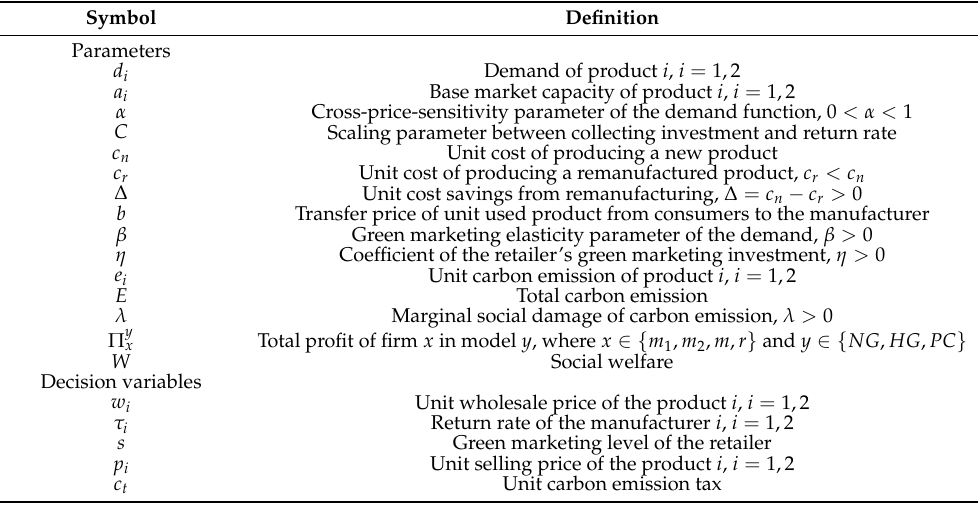
Table 2. Model parameters and decision